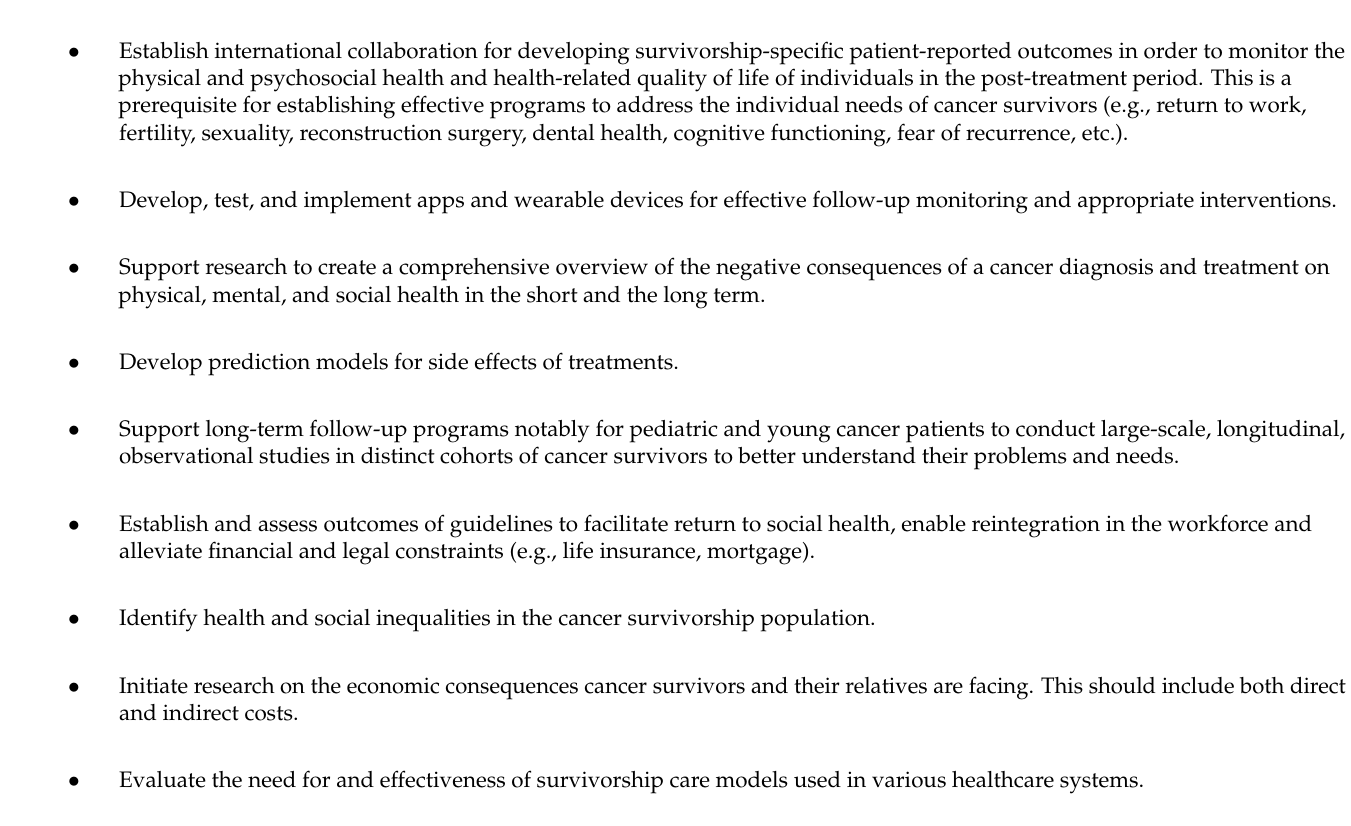
Table 1. European Union recommendations for psychosocial oncology, rehabilitation, and survivorship research